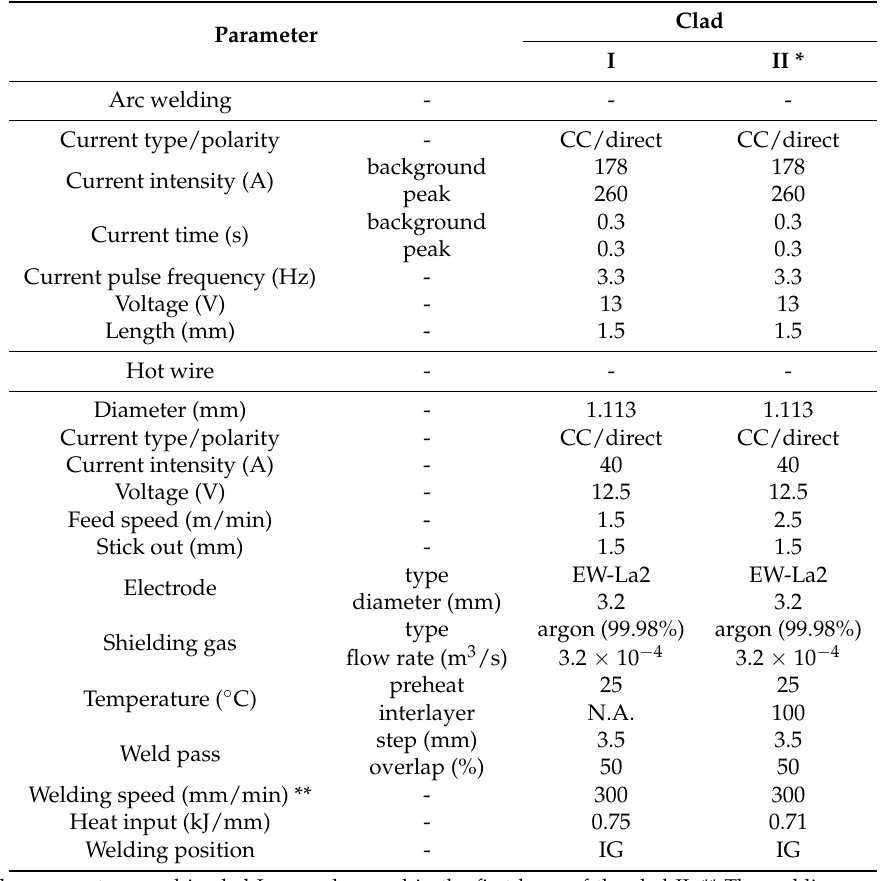
Table 3. Parameters used for overlaying a quenched and tempered 9%Ni steel (ASTM A333 Gr. 8) pipe with Ni-based super alloy 625 (AWS ER NiCrMo-3) by GTAW-HW